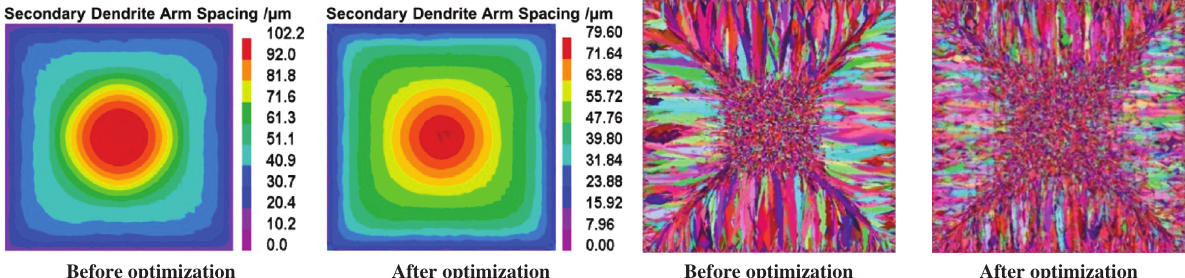
Figure 9. The macrostructure of test billet cross section before and after optimization is shown in Figure 11.